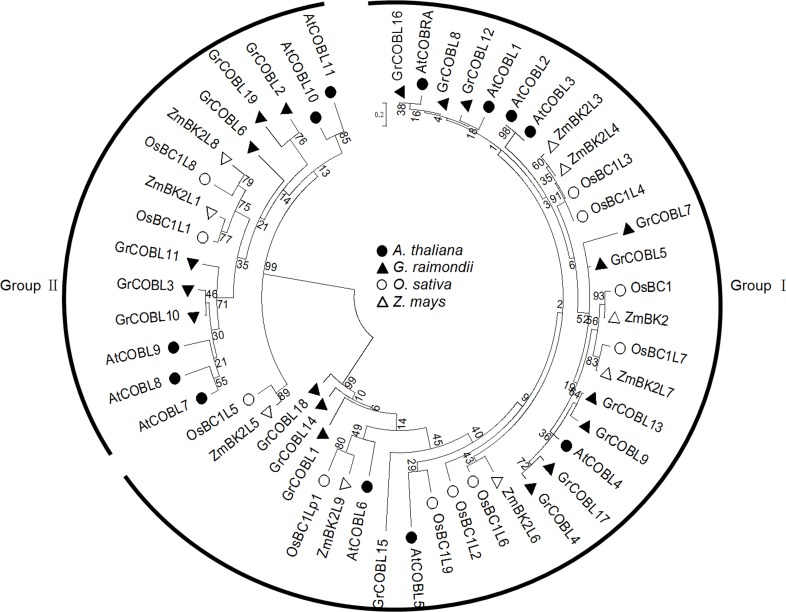
Phylogenetic analyses of COBL family genes in eudicot (A. thaliana, G. raimondii) and monocot (O. sativa, Z. mays).Amino acid sequences were aligned using ClustalW and the phylogenetic tree was conducted using MEGA 5.0 software with the maximum likelihood method. Four different color fonts were represented for the four species.